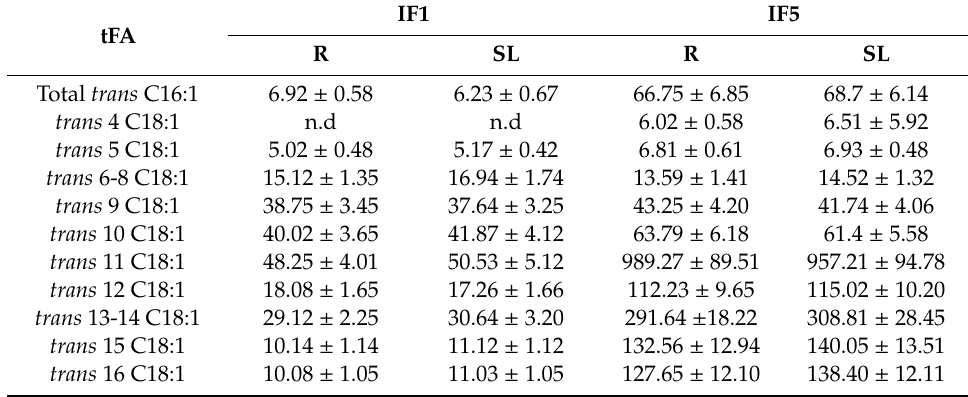
Table 2. Trans monoenoic fatty acid isomers composition (mg FA / 100 g of total FA ± Standard Deviation (SD) at the reception (R) and at the end of shelf life (SL) in commercial infant